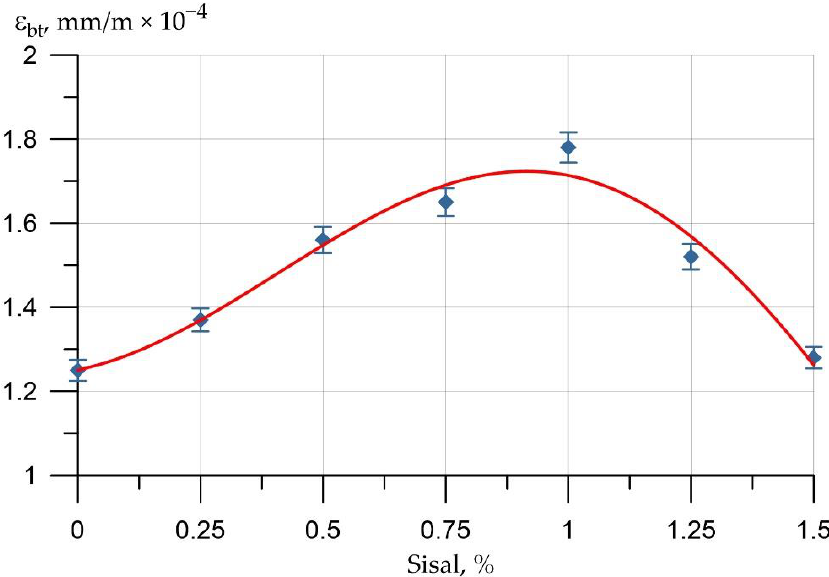
Figure 9. Results of experimental studies of ultimate strains in axial compression ε b of test concrete samples in the form of prisms at various percentages of reinforcement with sisal fibers.